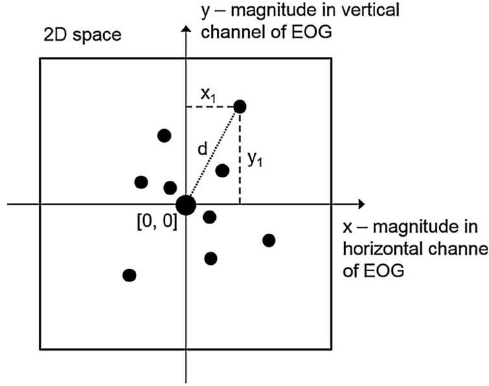
Fig. 13 Euclidean distance difference of a single feature